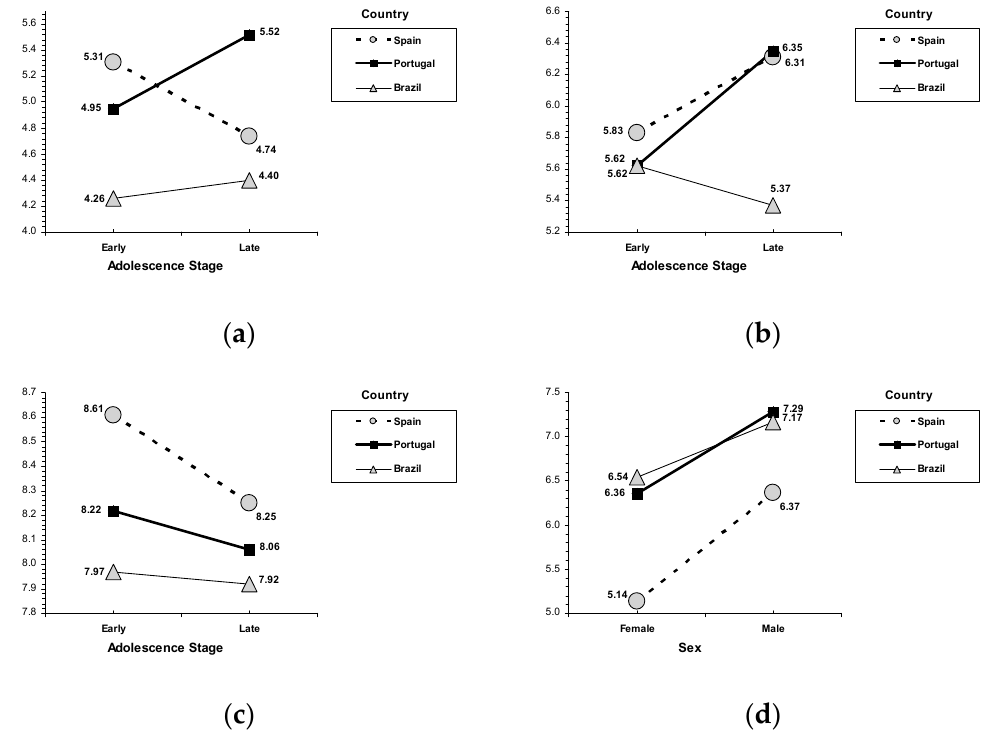
Figure 1. Interaction for sex, age and country, ( a ) emotional self-esteem for females, ( b ) emotional self-esteem for males. Interaction for adolescent stage and country, ( c ) family self-esteem. Interaction for sex and country, ( d ) physical self-esteem.